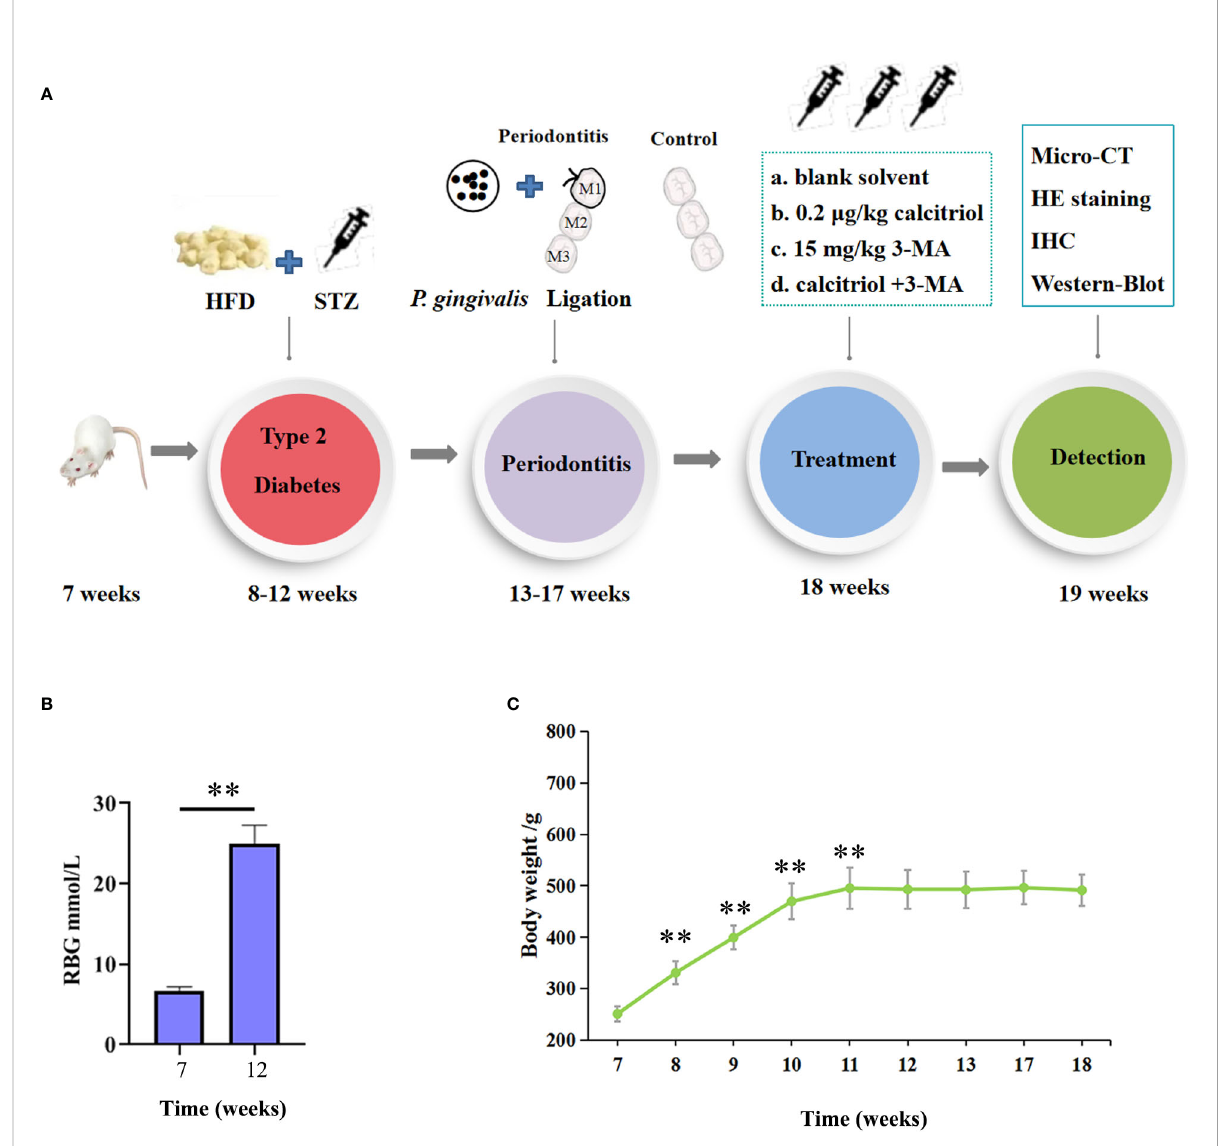
FIGURE 1 Establishment of the experimental type 2 diabetic model in rats. (A) The fl ow chart of the experimental design. HFD, High-Fat Diet; STZ, streptozotocin (35 mg/kg); HE, hematoxylin and eosin; IHC, immunohistochemical. (B) The random blood glucose (RBG) of the rats were measured. (C) Body weight of the diabetic rats were measured. The data were presented as the mean ± SD (n=4/group, ** P <0.01, compared with 7